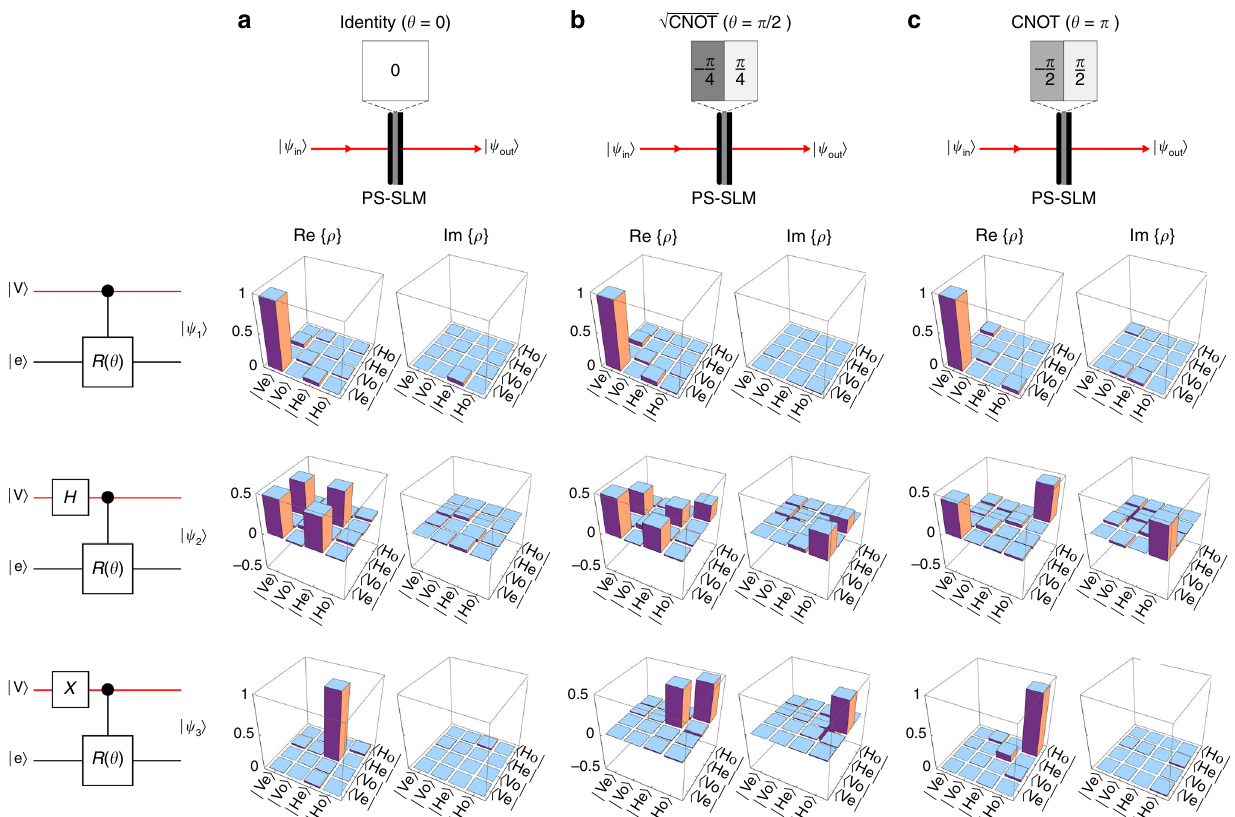
Fig. 5 Two-qubit single-photon quantum logic gates. Characterization of three two-qubit quantum gates on the space of polarization and x -parity: a the ffiffiffiffiffiffiffiffiffiffiffiffiffiffi p identity gate; b the gate; and c the CNOT gate. For each gate, we show the phase implemented on the PS-SLM (Fig. 4), and the real and imaginary CNOT parts of the density matrix Re{ ρ } and Im{ ρ }, respectively, reconstructed from quantum-state-tomography measurements at the quantum gate output for three different input states. The SLM implements a phase-step θ along x , a θ = 0, b θ = π , and c θ = π ( top row ) to create the desired gates. The three input 2 states Ψ in j i are (ordered in the rows from top to bottom ): (1) the initial separable generic state Ve j i produced by the heralded source in Fig. 4; (2) 1 ffiffi p H j i þ V j if g (cid:3) e j i obtained by rotating the polarization 45° (corresponding to the Hadamard gate H , a half-wave plate rotated 22.5°); and (3) He j i 2 obtained by rotating the polarization V j i → H j i (corresponding to the Pauli- X operator, a half-wave plate rotated 45°). On the leftmost column we